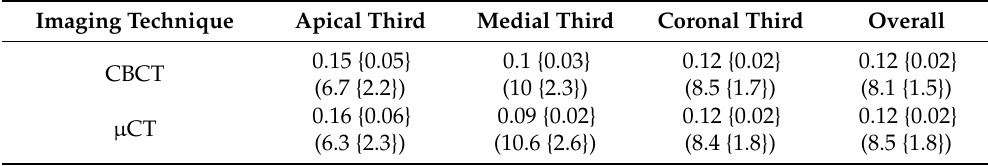
Table 2. Median and quartile deviation of canal curvatures ( n = 50).